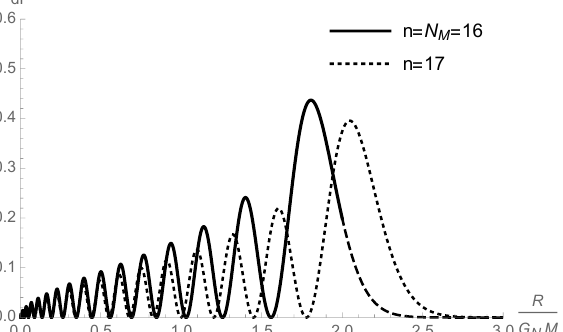
Figure 1. Probability density that the ball has radius R , for ground state with n = N M = M 2 / m 2 p : solid (dashed) line represents the region inside (outside) the gravitational radius R H = 2 G N M ; dotted line is same probability density for first excited state with n = N M +